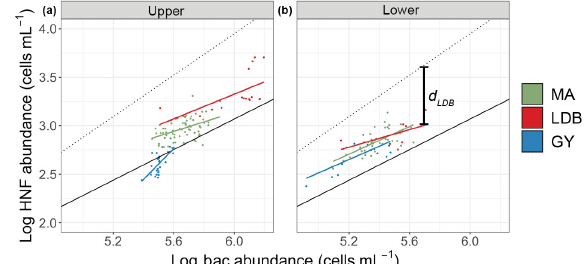
Figure 6. Log–log plot of Z u bacteria and HNF abundances (up- per, a ) and log–log plot of Z l bacteria and HNF abundances (lower, b ). Dots correspond to observed abundances, grouped by condition. Solid color-coded lines are regressions for abundance data corre- sponding to each biogeochemical condition. The solid black line corresponds to the regression line for mean realized abundances in marine environments (logMRA = 0 . 79 × logBac − 1 . 67). The dot- ted line corresponds to the theoretically maximum attainable abun- dance (logMAA = 1 . 07 × logBac − 2 . 47), as described in Gasol et al. (1994). d LDB included for clarification of the d